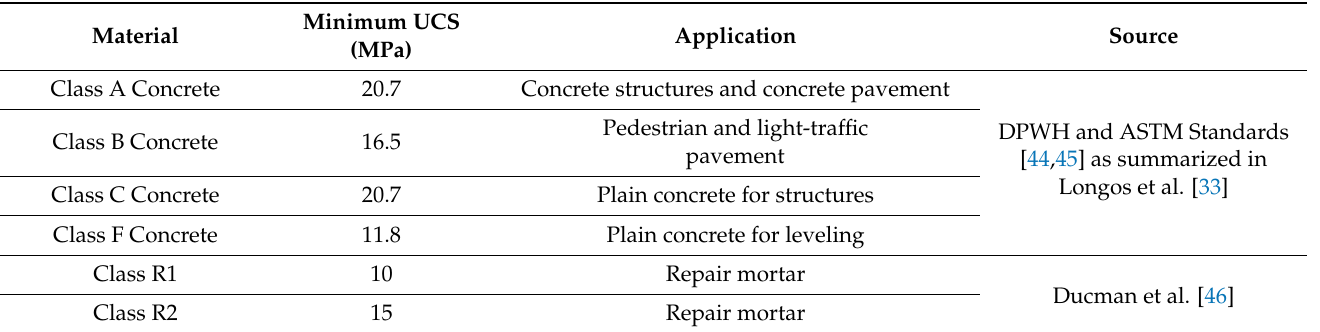
Table 13. Applications of OPC with compressive